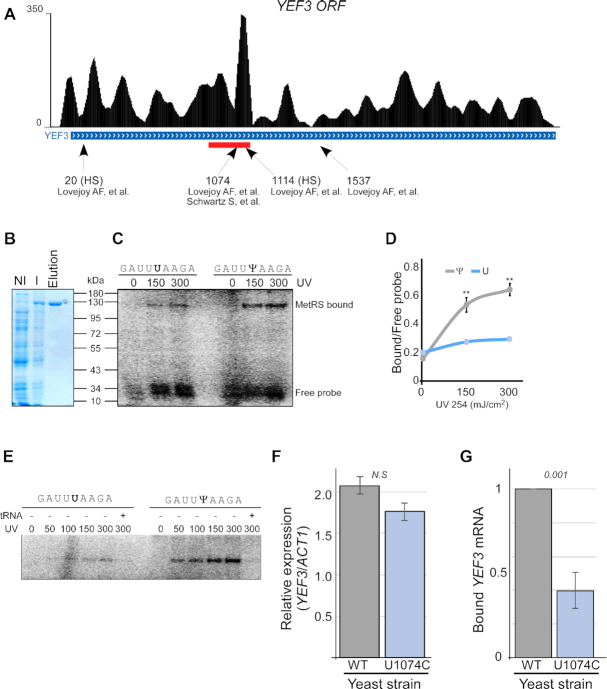
MetRS binds YEF3 mRNA at Ψ1074. (A) Genome browser map showing fRIP-seq coverage along YEF3 mRNA (UCSC Genome Browser). Red bar under the map indicates the MetRS binding region, as identified by the MACS2 callpeak (40). Arrows point to Ψ positions revealed by (18,19) along YEF3 ORF. HS indicates sites apparent upon heat shock. (B) Coomassie blue staining of MetRS purification steps. Noninduced lane (NI) contains a protein sample from bacteria transformed with MBP-MetRS plasmid before induction. Input (I) contains a protein sample from bacteria after expression induction. Elution includes the protein sample eluted from the MBP column. (C) Labeled 9-mer oligonucleotide (identical to the sequence surrounding Ψ1074), either with or without Ψ at its center, was UV-crosslinked to the indicated extent with purified MetRS and resolved on PAGE. Gel was dried and exposed to a phosphorimager. (D) Quantification of the MetRS-bound oligo to free oligo ratio from two independent crosslinking experiments. ** indicates P -value ≤0.01 for the difference between Ψ and U containing oligos at each UV exposure. Note that error bars for the U oligo are smaller than the data points. (E) UV crosslinking was done at the indicted amounts. Competitor cold yeast tRNA was added prior to crosslinking where indicated. (F) Point mutation was introduced by CRISPR/Cas9 into the genomic site of YEF3, replacing the encoded U1074 with C. Steady-state levels of wildtype (WT) and mutant (U1074C) YEF3 mRNA were quantified by RT-qPCR analysis from three independent biological repeats, each with three technical repeats, normalized to ACT1 mRNA levels. (G) MetRS-GFP expressing yeast strains, co-expressing endogenously either WT or U1074C YEF3 mRNA, were subjected to RIP. Amounts of bound YEF3 mRNAs were quantified by RT-qPCR analysis and normalized to their expression levels. The histogram presents the quantification of two independent biological repeats, each with three technical repeats. P-value was calculated by the dependent samples one-tailed t-test.